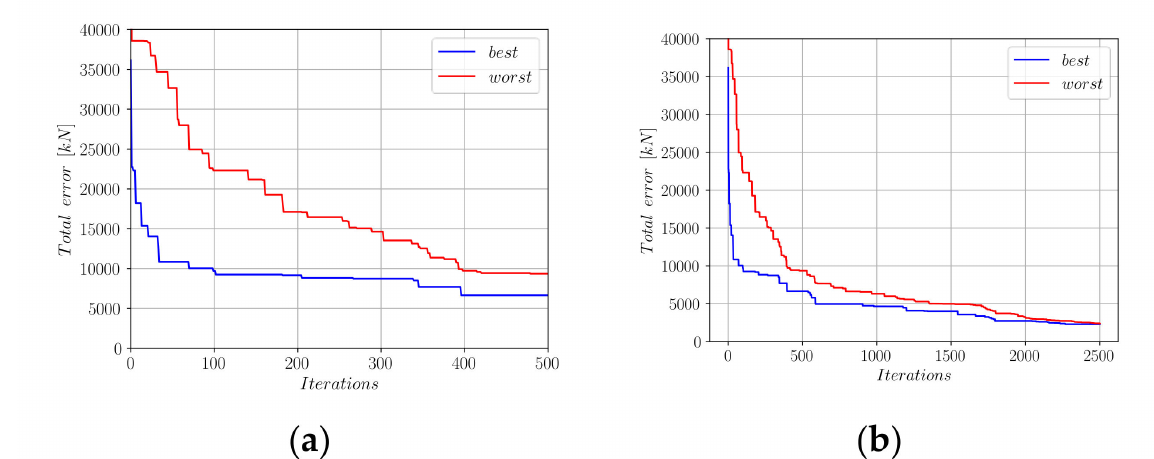
Figure 12. Decrease in the total error throughout the harmony search iterations (Equation (23));